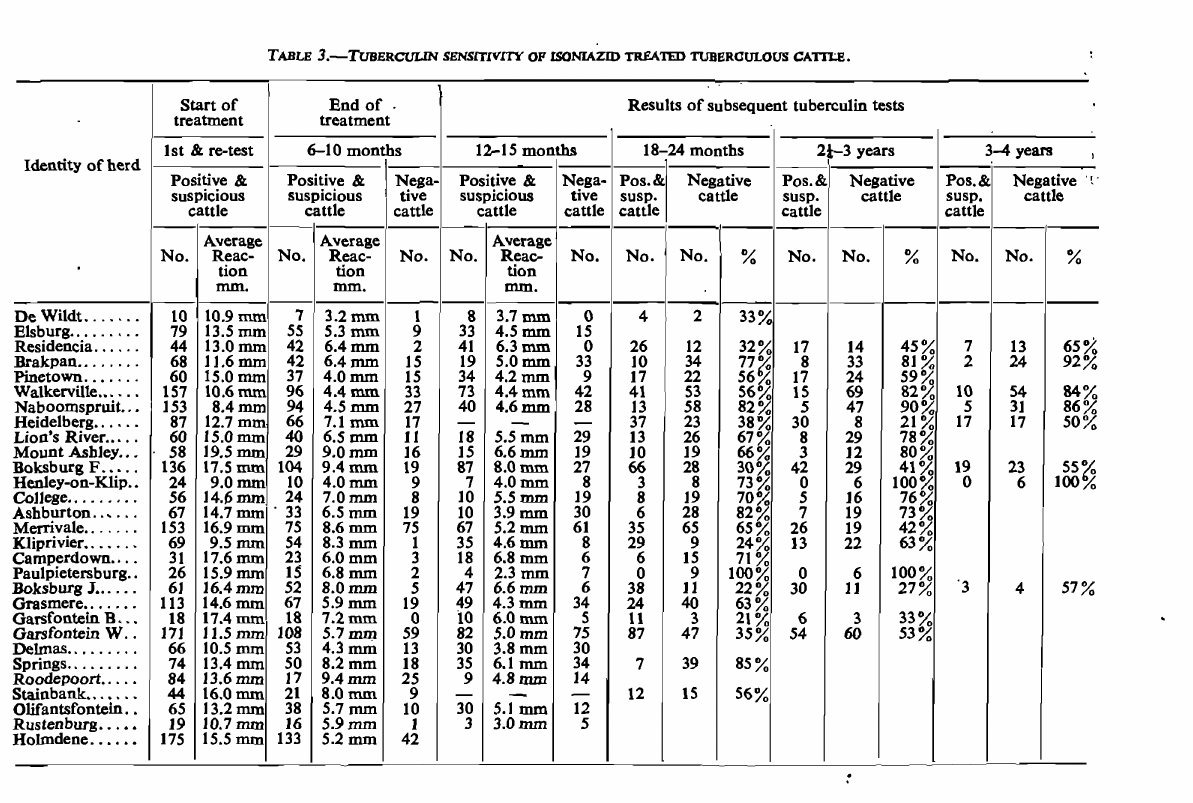
TABLE 3.-I't1BBRCULIN SENSlTNlTY OF lSONrAZm TR£ATED TIJIIBRCULOUS CATnI!. Start of Bnd of